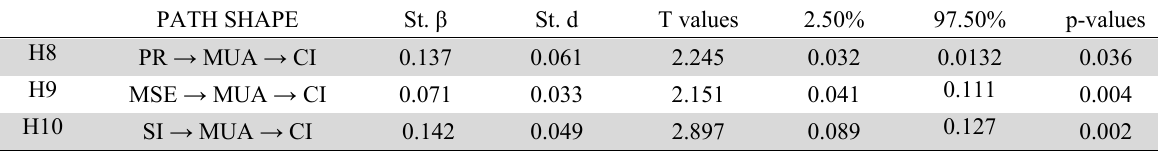
Mediating Effect of Mobile User Awareness PATH